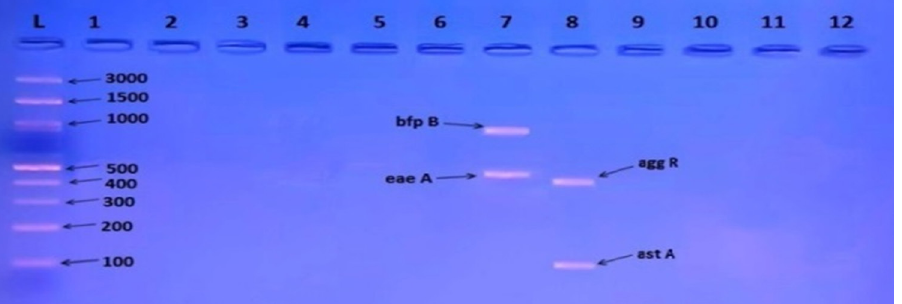
Fig. 6 . Gel electrophoresis of amplified ( eaeA, bfpB, aggR, astA, pic, hly, stx1, stx2, invE, ipaH, elt, estIa, estIb ) genes, the product size (482, 910, 400, 102, 1, 111, 688, 244, 324, 766, 437, 655, 157, 171 (bp) respectively), of E .coli strains using conventional PCR. Agarose 2%, and TBE (1X) at (75 V/cm for 90 min., stained with Ethidium bromide dye and visualized on a UV transilluminator. Lane (L): DNA ladder (100-3000 bp), Lanes: (1-12) stool samples.